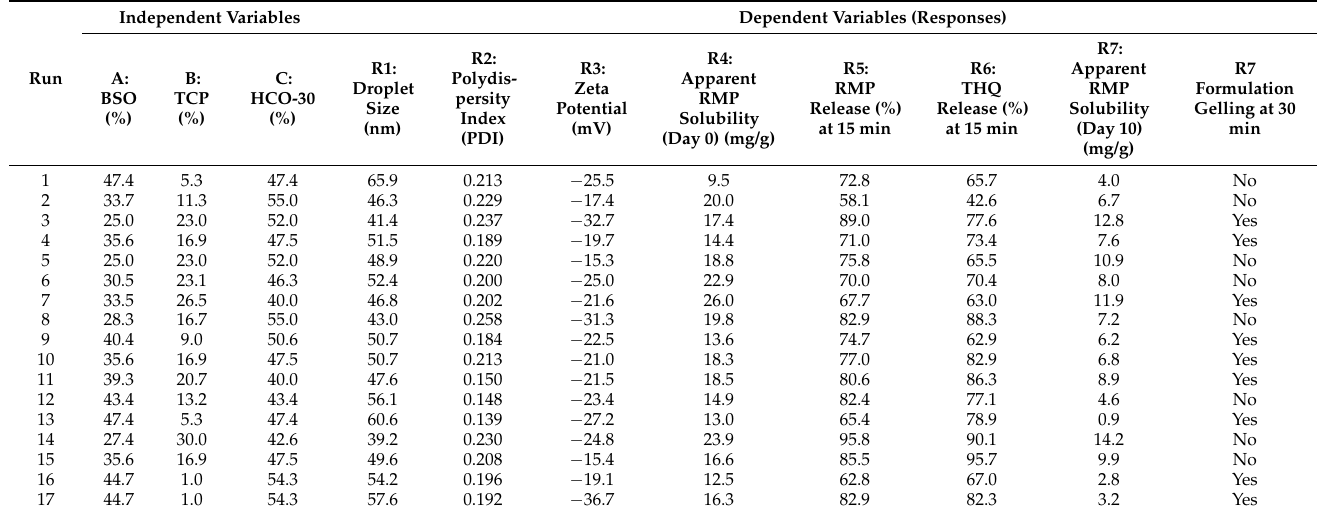
Table 2. Suggested RMP/THQ SNEDDS formulations and their corresponding actual responses.